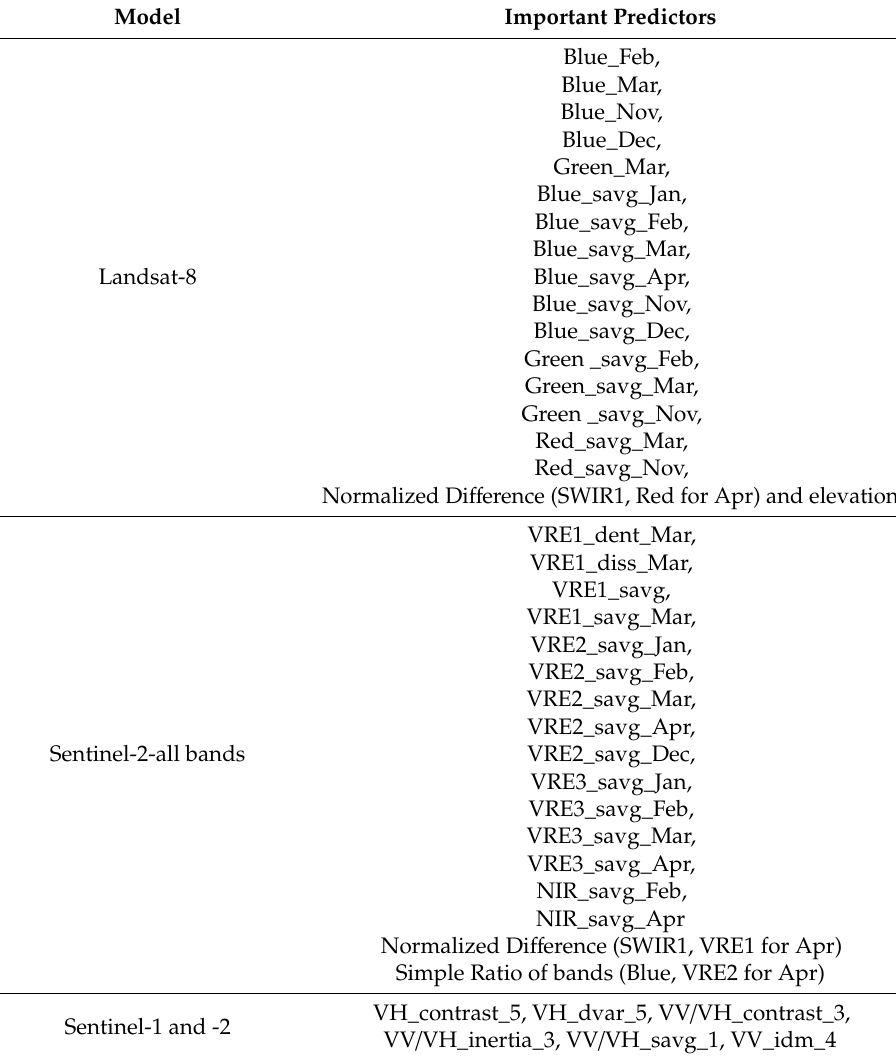
Table 4. Important predictors in each model.